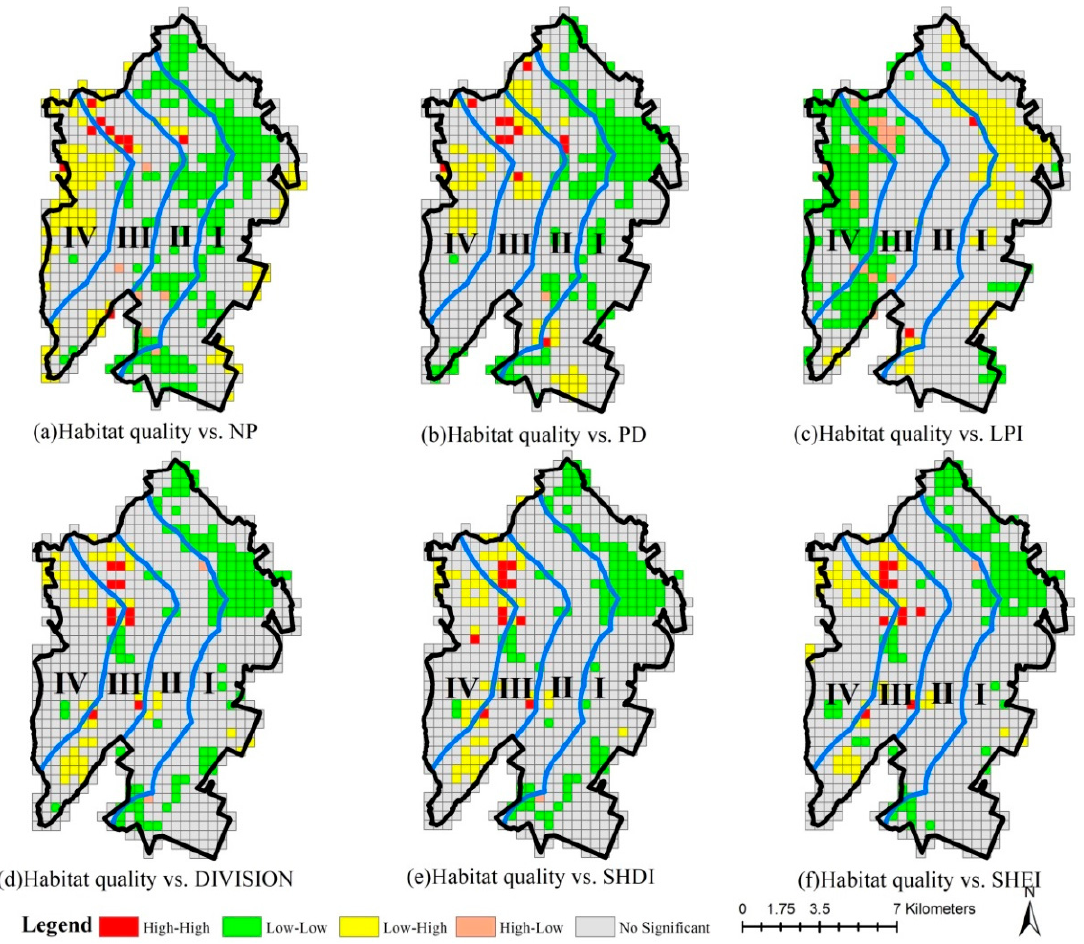
Figure 8. LISA cluster map between habitat quality variation and landscape metric changes from 2005 to 2020. (Gradient I (0–2 km), gradient II (2–4 km), gradient III (4–6 km) and gradient IV (>6 km) from the coastline to the inland).